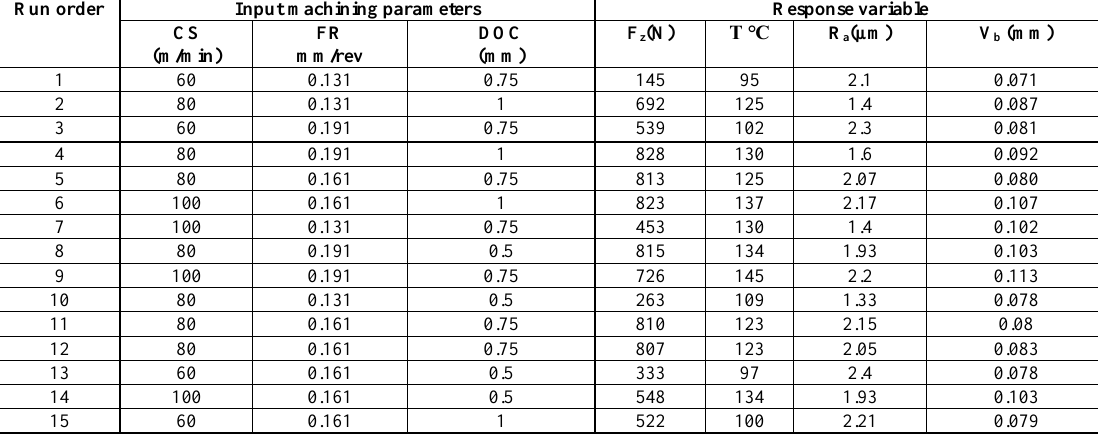
Table 3. Machining input cutting conditions and four response